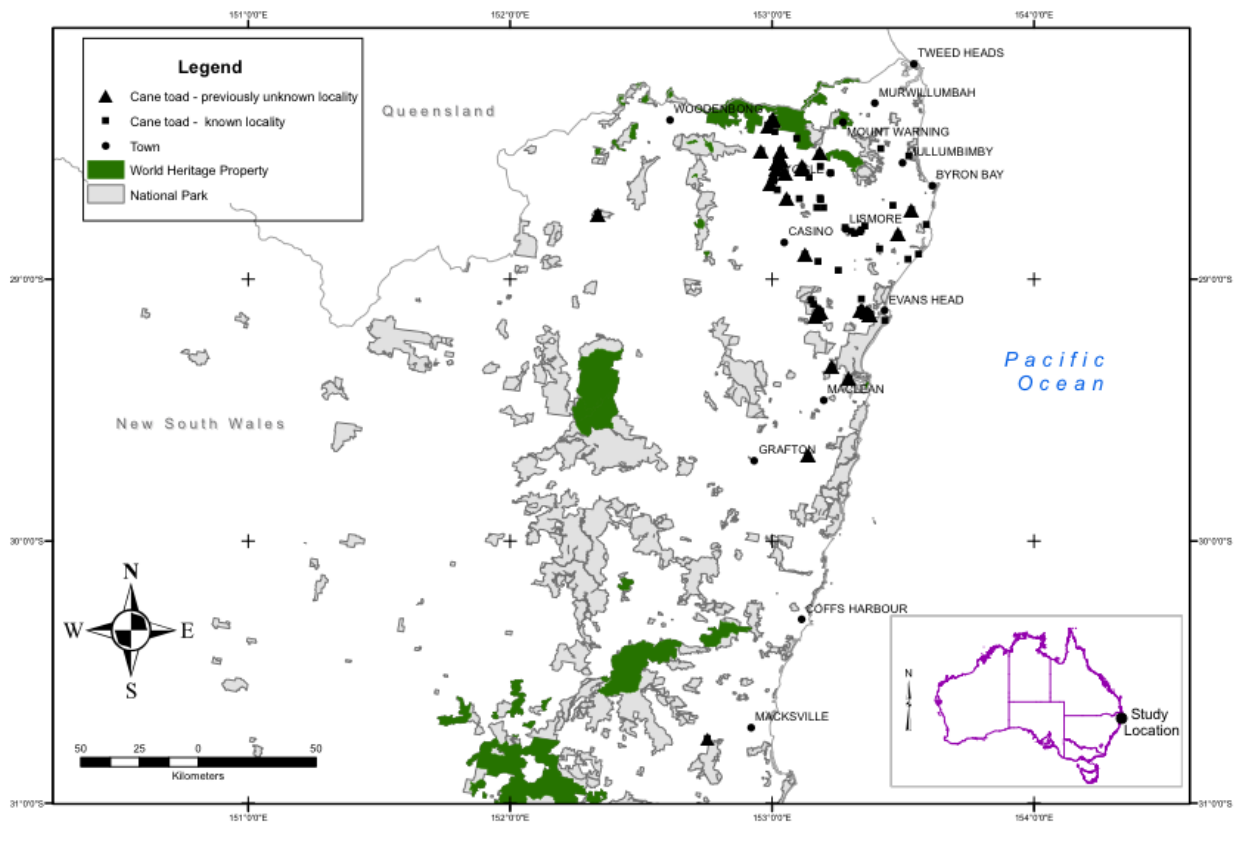
Figure 4. Distribution of records of cane toad observations collected using the Toad Tracker interface, and illustrating the distribution of records outside the previously known